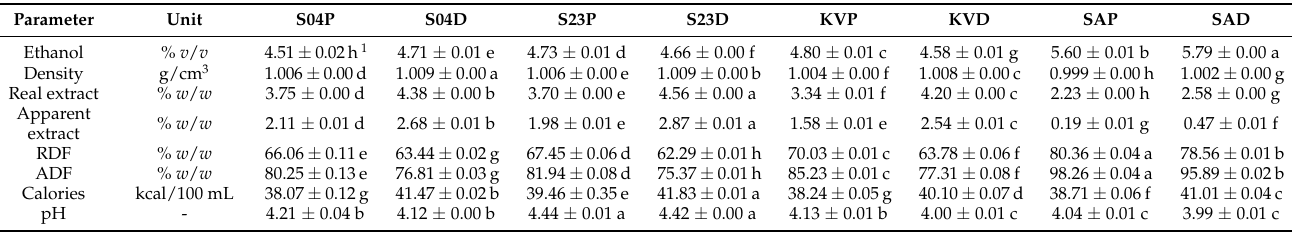
Table 2. Physicochemical parameters of